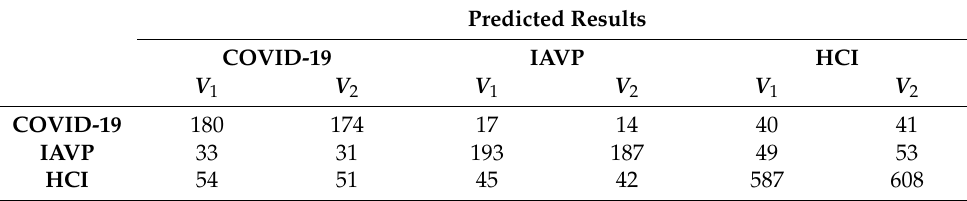
Table 2. Model performance evaluation metrics on recall, precision, and f1-score of both classification models for COVID-19, IAVP, and a Healthy Candidate without infection (HCI).